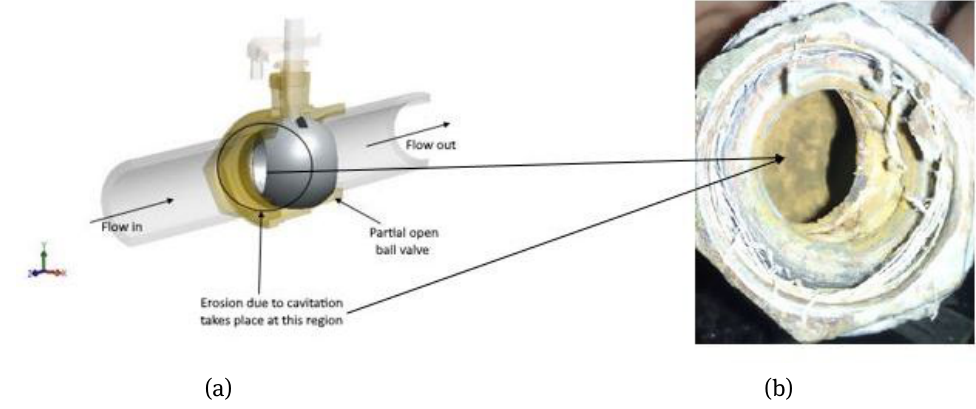
Figure 5: (a) – Cross-sectional view of the ball valve. (b) – Erosion shown in the partially open ball valve